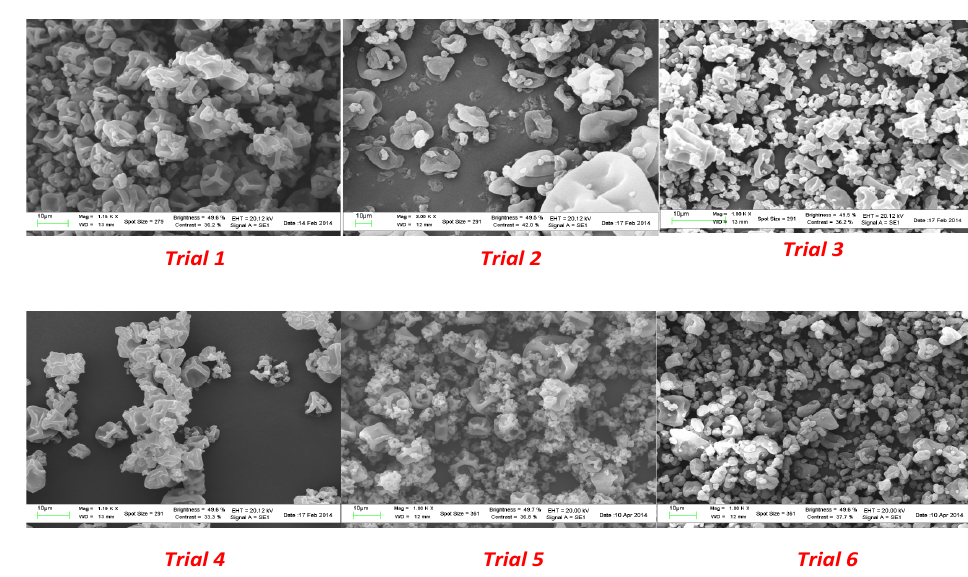
Figure 3. SEM images of microparticles from spray drying experiments.